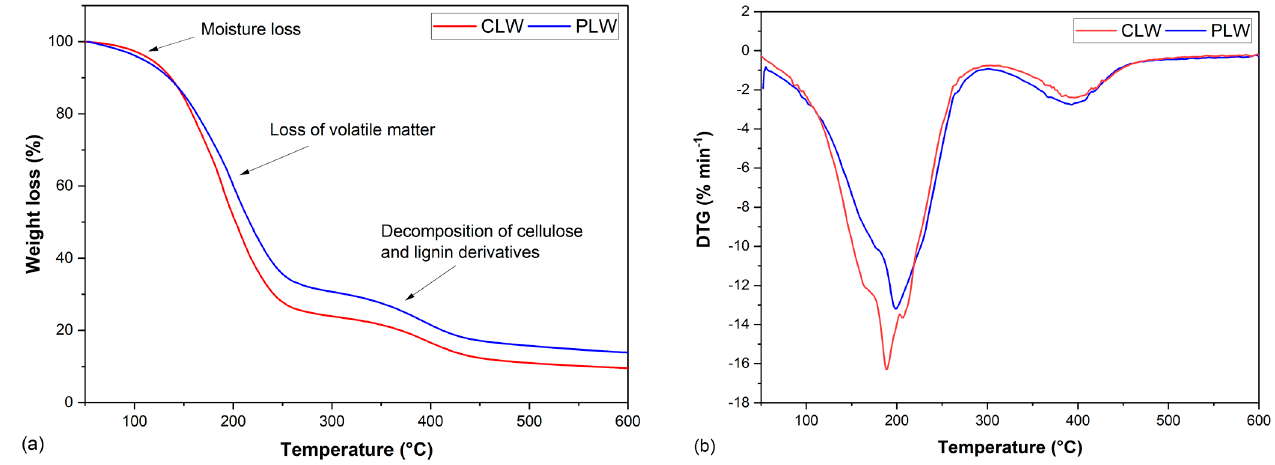
Figure 3. ( a ) Mass loss of bio − polyols; ( b ) Derivative weight of bio − polyols. Table 4. Thermal degradation properties of bio − polyols.